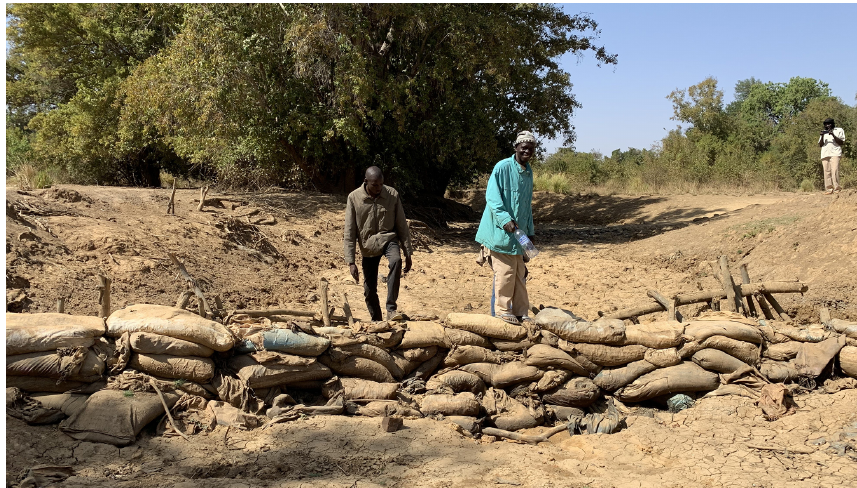
Figure 13. Photo of the handmade dam at the outlet of Lac Wégnia (9 February 2020, source: Tobias Siegfried).